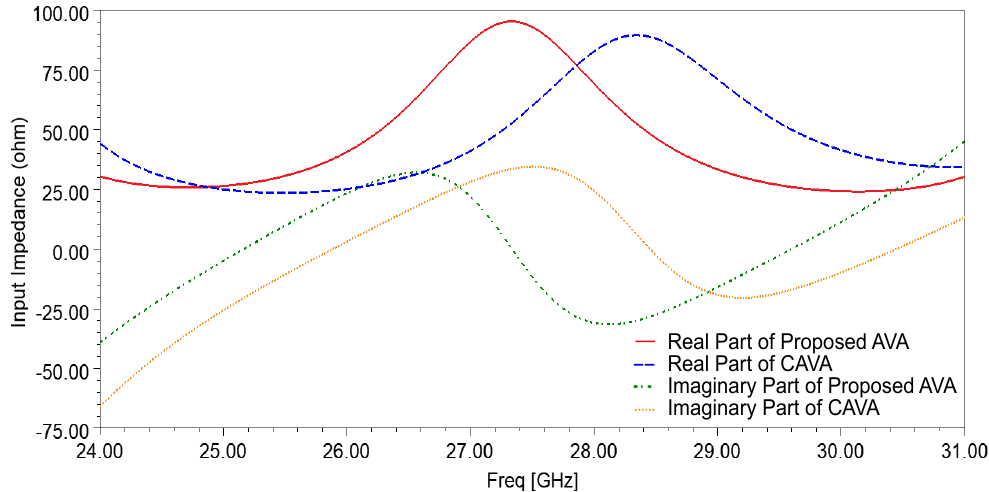
Figure 2. Input impedance of the single-patch AVA with and without corrugations.